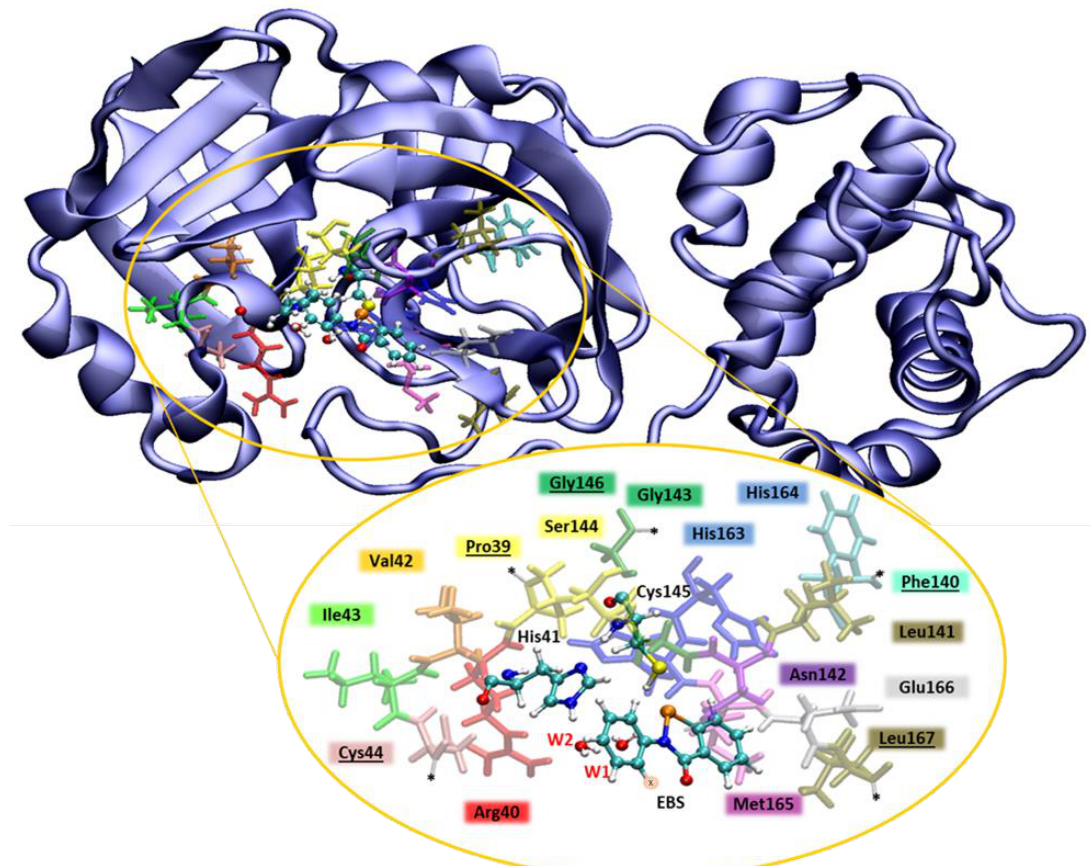
Figure 3. M pro cartoon representation. In the yellow circle the QM-cluster model of 312(3) atoms for EBS (EBS-OH). Amino acid residues are shown in sticks and colored by residue name, the catalytic dyad (Cys145, His41), EBS and water molecules W1 and W2 are in balls and sticks. Stars on residues Pro39, Cys44, Phe140, Gly146 and Leu167 point to frozen atoms and delimit the model truncations.